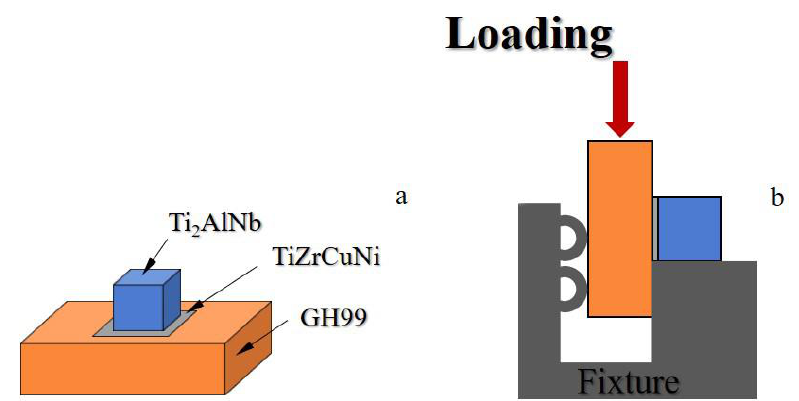
Figure 2. ( a ) Brazed joint assembly diagram; ( b ) shear test diagram.